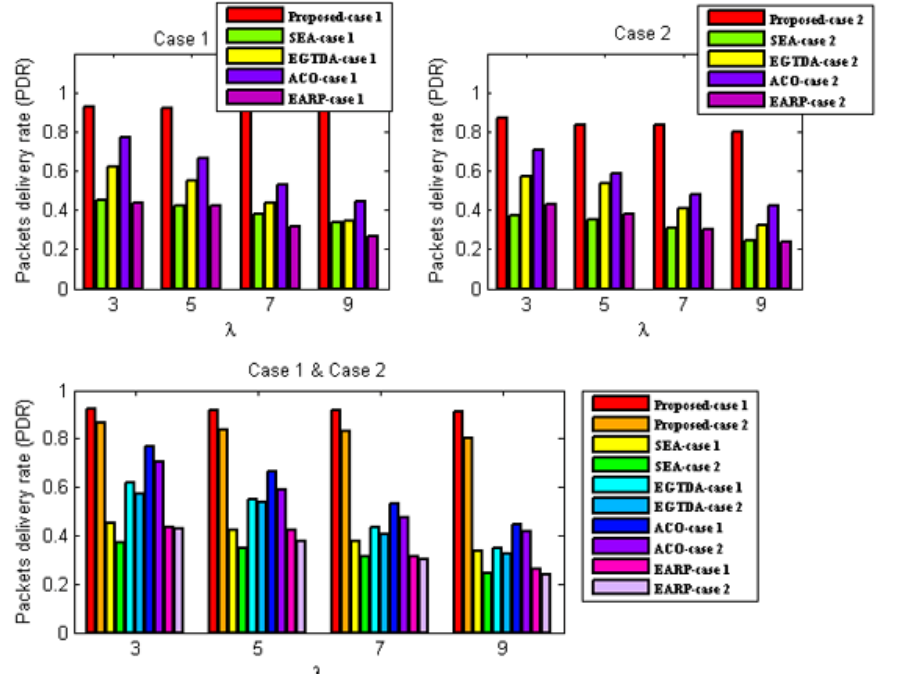
Figure 9. Influence of increasing average traffic rate on packets delivery ratio under the second sce- nario.